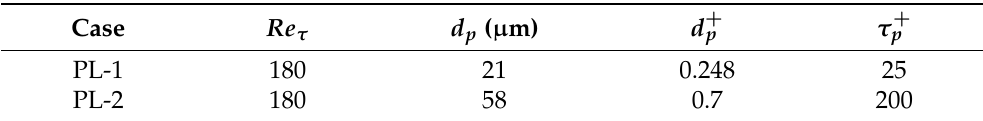
Table 1. Particle diameter and relaxation time used in validation tests. PL − 1 and PL − 2 are case designations.